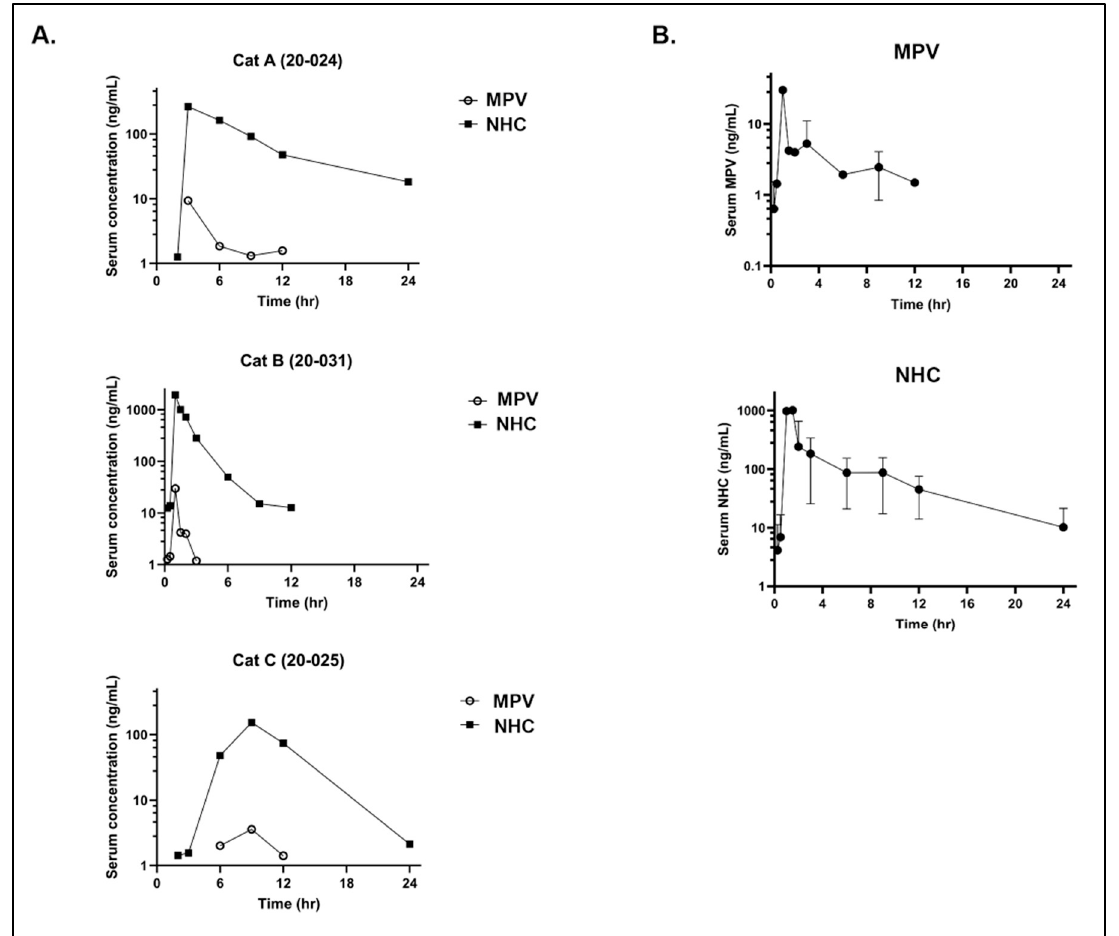
Figure 3. Serum detection of prodrug MPV and the metabolite NHC over a 24-h time period in cats. ( A ) Detection of MPV and NHC in the serum (ng/mL) of each individual cat over 24 h. ( B ) Combined detection of MPV and NHC in three cats over 24 h.